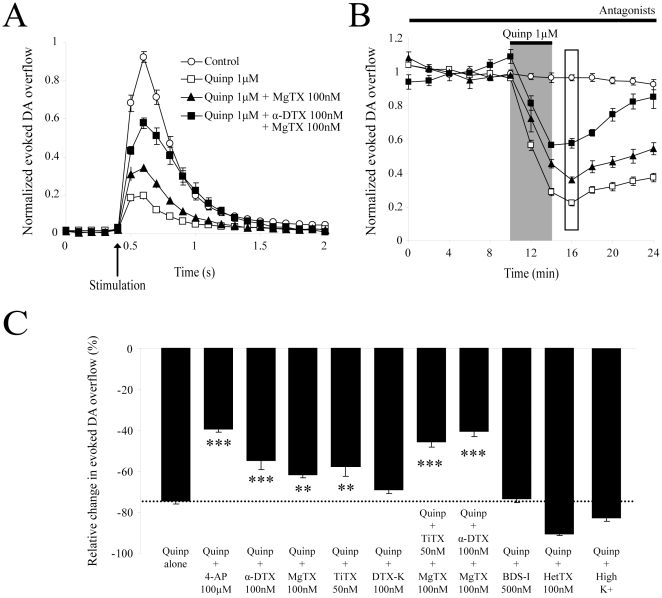
Regulation of D2-mediated inhibition of DA release by Kv1 potassium channels.(A) Applied alone for 4 min, 1 µM quinpirole (n = 27;18) induced a large inhibition of evoked DA overflow compared to control (n = 8;6). Pre-application (30 min) of 100 nM MgTX (n = 5;3) or a combination of both 100 nM MgTX and 100 nM α-DTX (n = 4;2) reduced the effect of quinpirole. Data were normalized to the first 6 recordings (10 min) of their respective control period (means ± SEM). The effect of others Kv subunits blockers is omitted for clarity. (B) Time-course of the experiment shown in A. DA was electrically-evoked at intervals of 2 min. Each group was normalized to the first 6 recordings (10 min) of its respective control period (means ± SEM). The maximal effect of quinpirole was detected after 6 min (represented by the rectangle). (C) Histogram showing the ability of potassium channel blockers selective for various Kv subtypes to reduce the effect of quinpirole (1 µM) on evoked DA overflow: quinpirole alone (n = 27;18, represented by the black doted bar), 4-AP (n = 6;2), 100 nM α-DTX (n = 6;4), 100 nM MgTX (n = 5;3), 50 nM TiTX (n = 6;2), 100 nM DTX-K (n = 6;3), 50 nM TiTX + 100 nM MgTX (n = 6;4), 100 nM α-DTX + 100 nM MgTX (n = 6;3), 500 nM BDS-I (n = 6;2), 100 nM HetTX (n = 6;2) and high concentration of potassium (n = 4;2). * p<0.05, ** p<0.01, *** p<0.001. Abbreviations: K+, potassium; 4-AP, 4-aminopyridine; α-DTX, α-dendrotoxin; MgTX, rMargatoxin; TiTX, rTityustoxin Kα; DTX-K, dendrotoxin-K; BDS-I, blood depressing substance I; HetTX, rHeteropodatoxin-2; quinp, quinpirole.